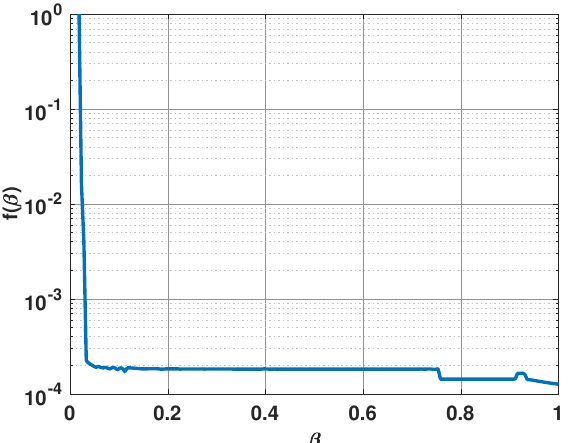
Figure 5. f ( β ) versus β for a uniform linear array of 15 elements in the presence of three signals at 55 ◦ , 75 ◦ , and 95 ◦